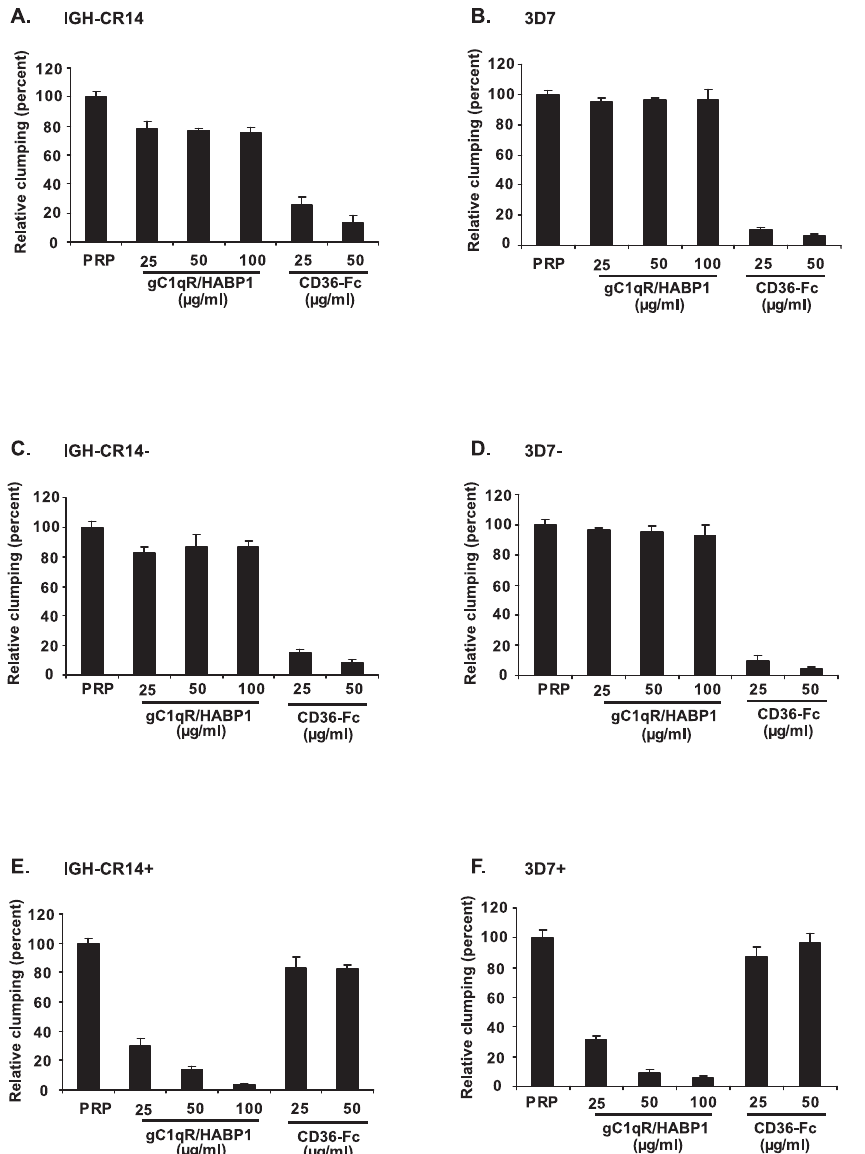
Figure 4. Inhibition of Platelet-Mediated Clumping of IRBCs by Soluble gC1qR/HABP1 and CD36-Fc Parasite cultures in trophozoite and schizont stages were allowed to form clumps in the presence of PRP. Parasites were stained with acridine orange and the clumping frequency was determined by scoring the frequency of IRBCs found in clumps. Approximately 2,000 to 3,000 IRBCs were scored. Parasite cultures were pre-incubated with recombinant gC1qR/HABP1 or CD36-Fc at different concentrations prior to use in clumping assays to test their ability to inhibit clumping. Clumping frequency in the presence of gC1qR/HABP1 or CD36-Fc is expressed as relative clumping compared to clumping in the presence of PRP alone. Data represent the average ( 6 standard error) of two independent experiments. Each assay was performed in duplicate. (A) IGH-CR14, (B) 3D7, (C) IGH-CR14 (cid:2) , (D) 3D7 (cid:2) , (E) IGH-CR14 þ , (F) 3D7 þ